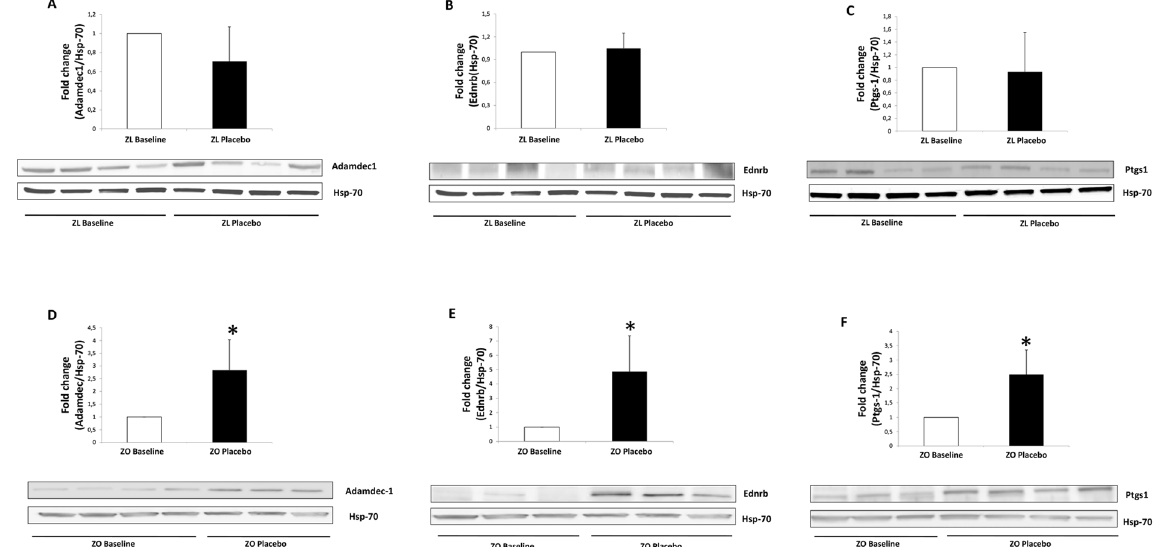
Figure 1. Western blot analysis of Adamdec1, Ednrb and Ptgs1 proteins from Zucker lean Lepr + / fa and Zucker- Lepr fa / fa rats both at baseline and after 30 days of placebo administration. Panels A–C show results for Zucker lean Lepr + / fa rats at baseline compared with Zucker lean Lepr + / fa rats fed the placebo for 30 days. Panels D–F show results for Zucker-Lepr fa / fa rats at baseline compared with Zucker-Lepr fa / fa rats fed the placebo 30 days. The top graph included 7–8 rats per group, and the lower part shows a representative crop blot. Hsp-70 was used as a loading control. ZL, Zucker lean Lepr + / fa rats; ZO, Zucker-Lepr fa / fa rats; * P < 0.05.